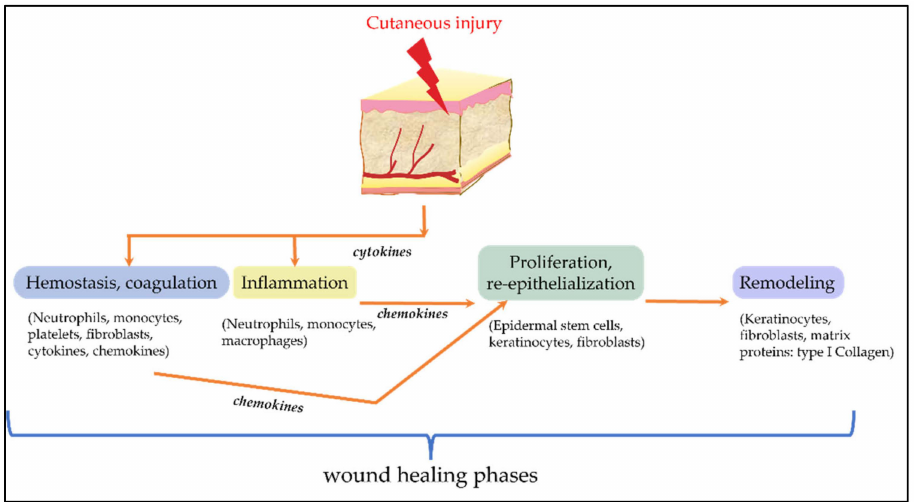
Figure 4. Cellular events involved in wound-healing. Wound-healing is a multi-phasic process involving cellular hemostasis, inflammation, proliferation, re-epithelialization, and remodeling. Cytokines and chemokines act as messengers to regulate these phases. Platelets, fibroblasts, immune cells, keratinocytes, and epidermal stem cells participate in this process. Remodeling through changes in ECM proteins and connective tissues comprises the final phase of wound-healing.